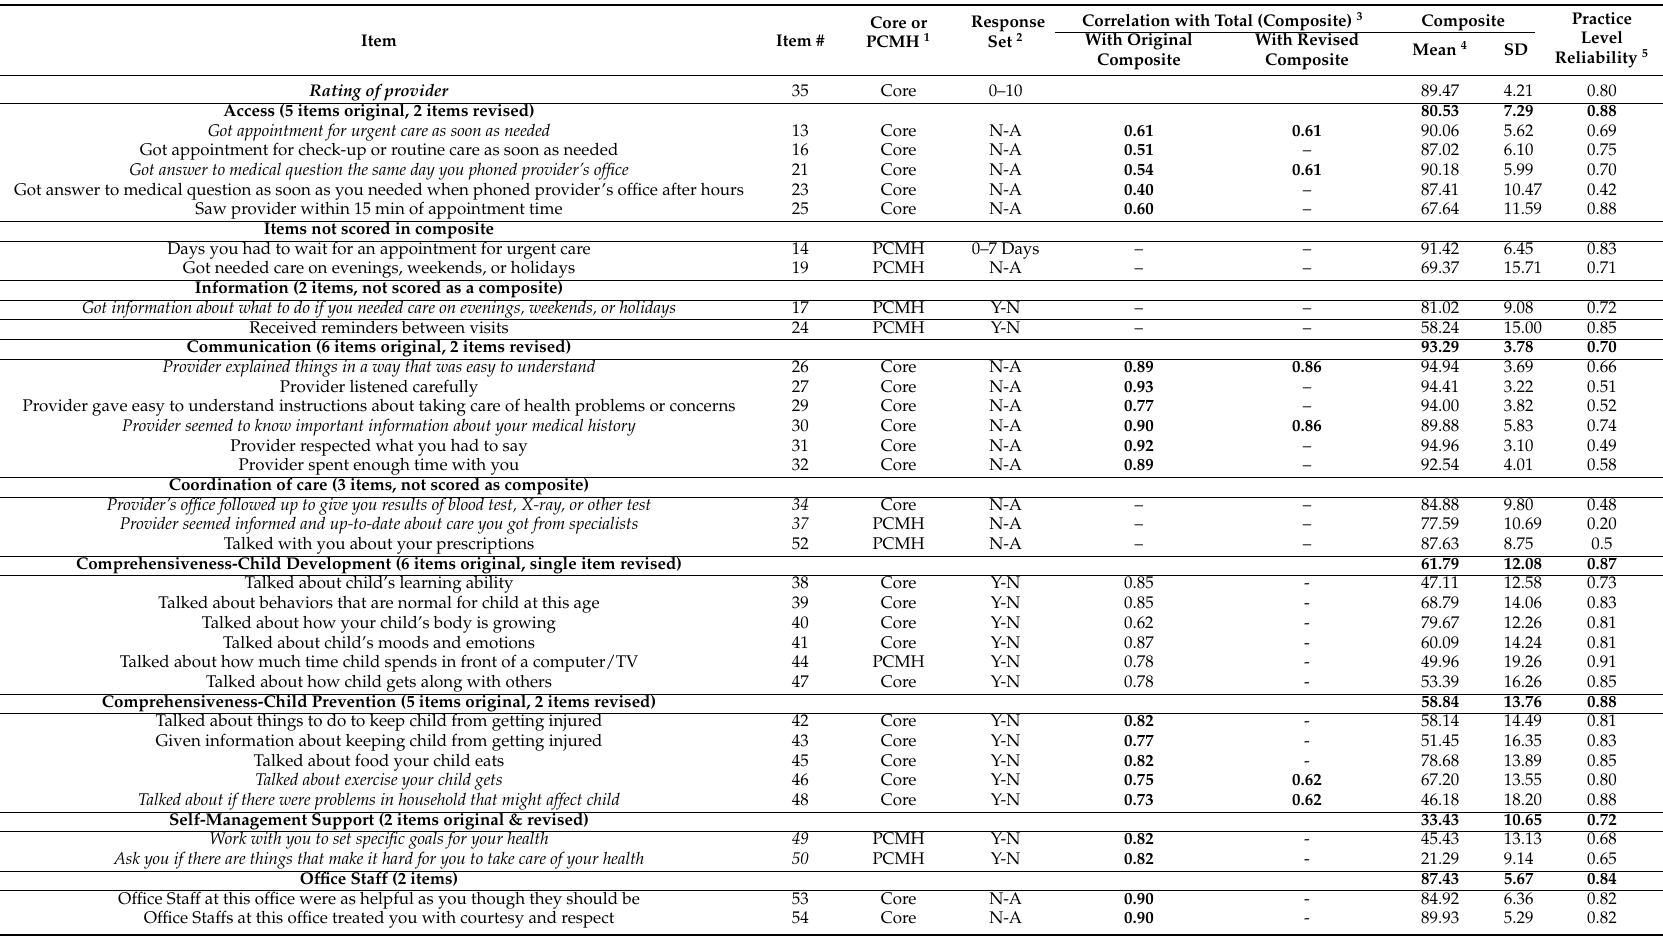
Table 3. 2013 results for the child CAHPS PCMH Survey ( n = 58 practices). Items in italics recommended for revised